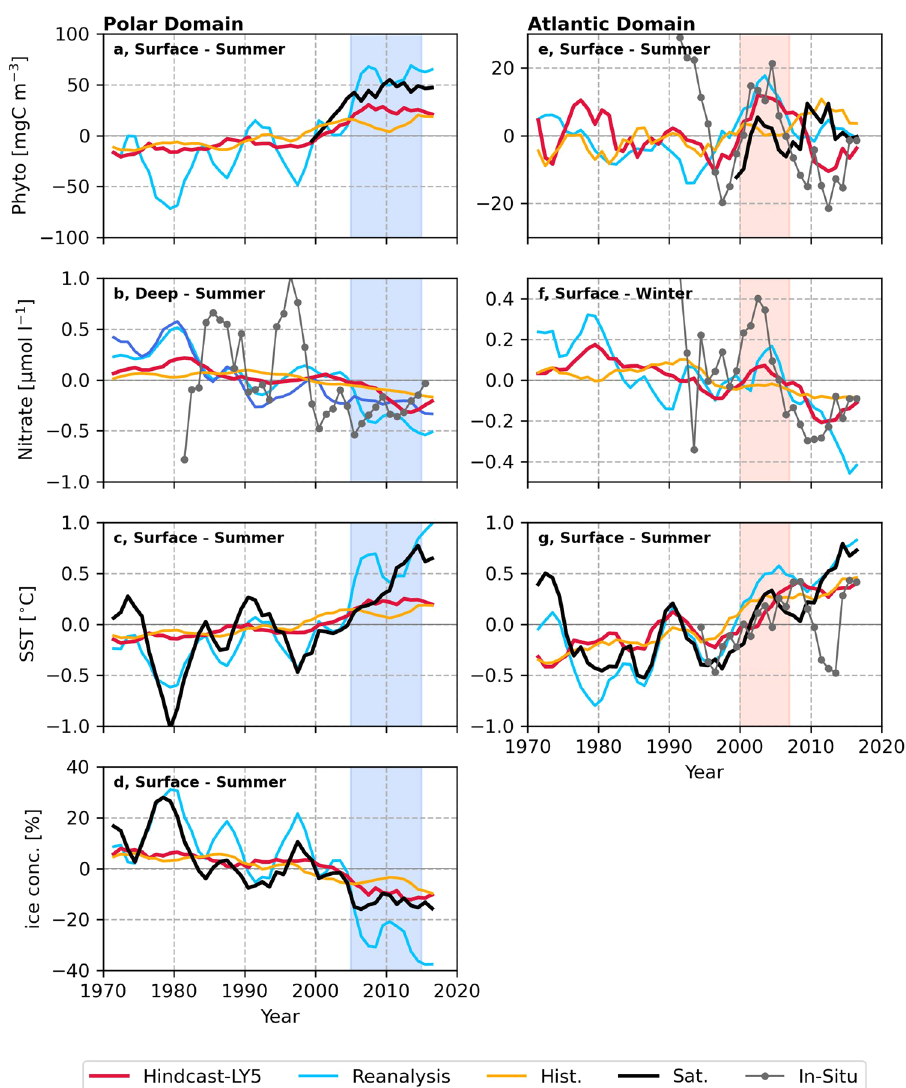
Fig. 2 Drivers of phytoplankton predictability. Anomaly time series of a , e phytoplankton concentration (mgC m − 3 ), b , f nitrate concentration ( μ mol l − 1 ), c , g sea surface temperature ( ∘ C), and d sea ice concentration (%) anomalies, from in situ measurements (gray line with points), satellite products (black), the historical simulation (orange), the reanalysis (blue) and the hindcasts at lead year 5 (red), in Polar Domain (left column) and Atlantic Domain (right column). The phytoplankton concentration, SST and ice concentration time series are the averages over May – July. For the nitrate time series in the Polar Domain, all available in situ data, mainly from the summer season, were used to construct the annual means, due to sparse sampling. These are compared to the summer (May – July) concentrations from the historical simulation, the reanalysis, and the hindcast. Here, the dark blue line shows the surface winter concentration for comparison. For the Atlantic Domain the winter nitrate concentrations (average over January – March) are shown. Note that all-time series have been fi ltered by a 4-year running mean. The shaded areas refer to time periods discussed in the the hindcasts and the observations, suggest that the prediction of the anomalously high phytoplankton is a result of the predict- ability of the nutrient levels at the start of the productive season. In addition, both the observational data and the hindcasts indicate an increased nutrient consumption in the period (Supplementary Fig. S5). Assuming a Red fi eld carbon:nitrogen ratio of 106:16 of the phytoplankton, the observed (modeled) nitrate drawdown of ~0.7(0.4) μ molN l − 1 corresponds to an organic carbon concentration of 56(32) mgC m − 3 , which is in good agreement with the observed (modeled) phytoplankton anomaly of 40(20) mgC m − 3 . A lower organic carbon concentra- tion in the phytoplankton biomass, compared to the converted nutrient drawdown, is expected due to grazing, exudation, and other loss processes. The good agreement between the nutrient